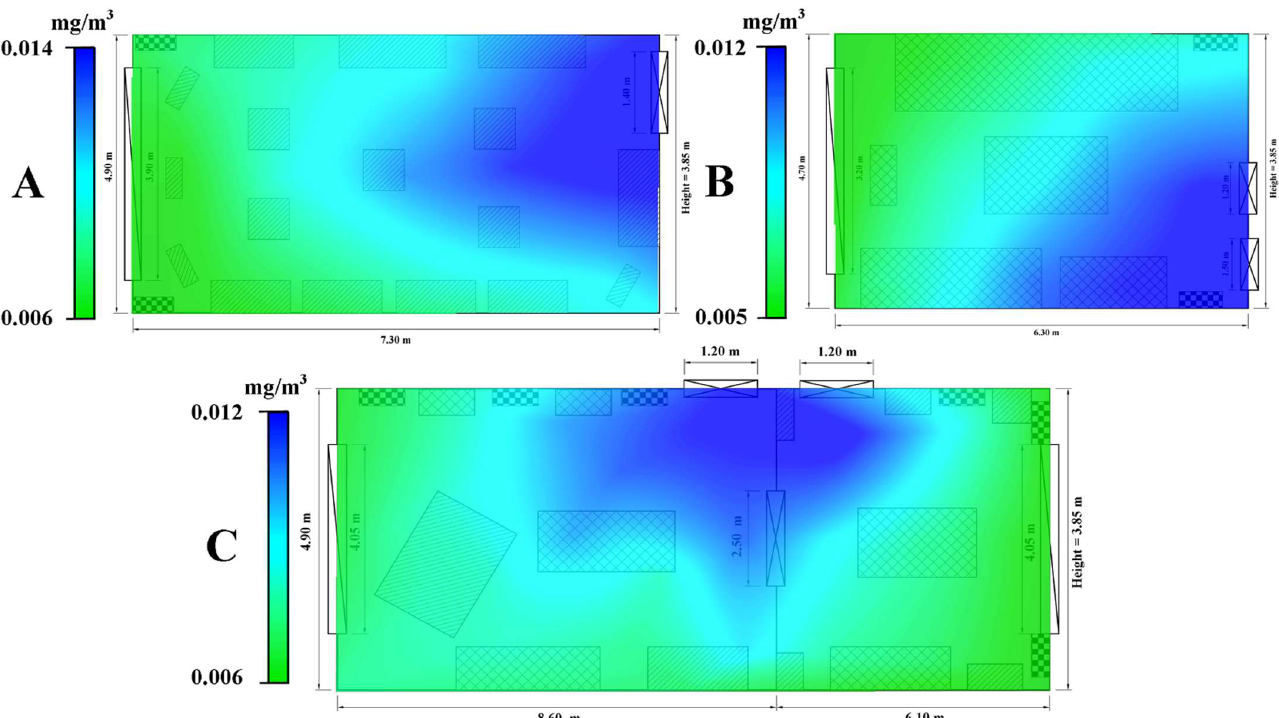
Figure 9. Spatial distribution of formaldehyde (HCHO) concentration values in the three analyzed rooms of Darvas-La Roche House–taking into account the average of each data collection position for the entire measured period (( A )—Exhibition hall–Ground floor; ( B )—Bedroom–1st floor; ( C )—The great hall–1st floor) .